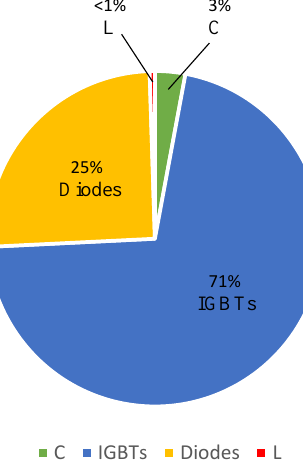
Figure 2. Distribution of the components failure